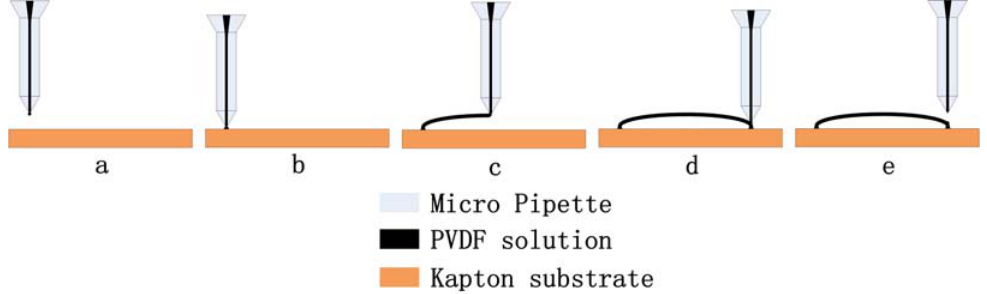
Figure 8. Schematic diagram of the drawing fabrication process of suspended aligned PVDF